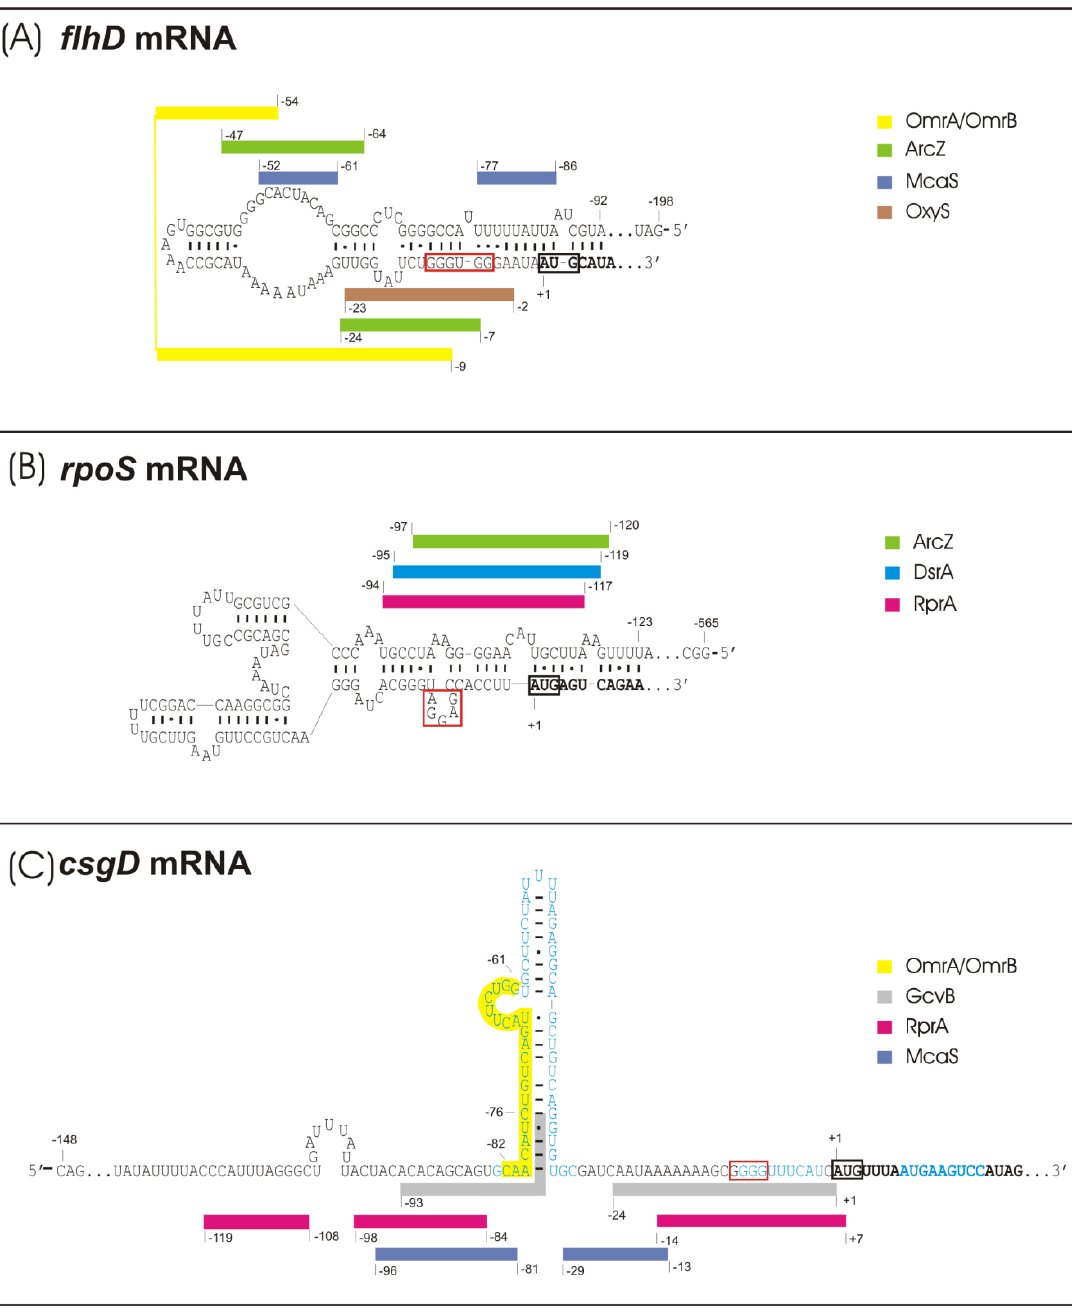
Figure 2. “hub” mRNAs—secondary structures of relevant 5'UTR parts and sRNA binding sites . ( A ) Structure prediction of flhD 5'UTR [61]. ( B ) Predicted and mapped structure of rpoS 5'UTR [74] ( C ) Predicted and mapped structure of csgD 5'UTR [75]. sRNA binding sites were computationally predicted and proven by compensatory basepair exchanges (all except GcvB) [41,60–62,64,75–77] or mapped [64,75]. Positions on the mRNA sequence are numbered according to the transcriptional start site. Bold nucleotides: coding region; black box: start codon; red box: Shine Dalgarno Sequence; colored bars: sRNA binding sites; blue nucleotides: unfolded stem loop